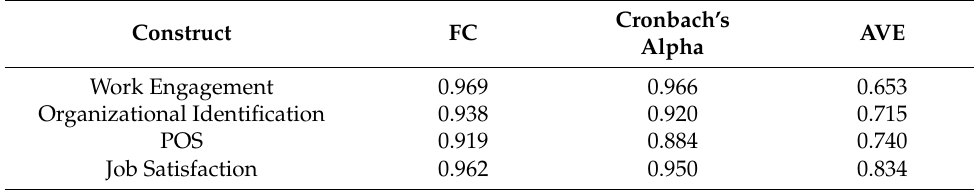
Table 2. Reliability and convergent validity of proposed model’s constructs.